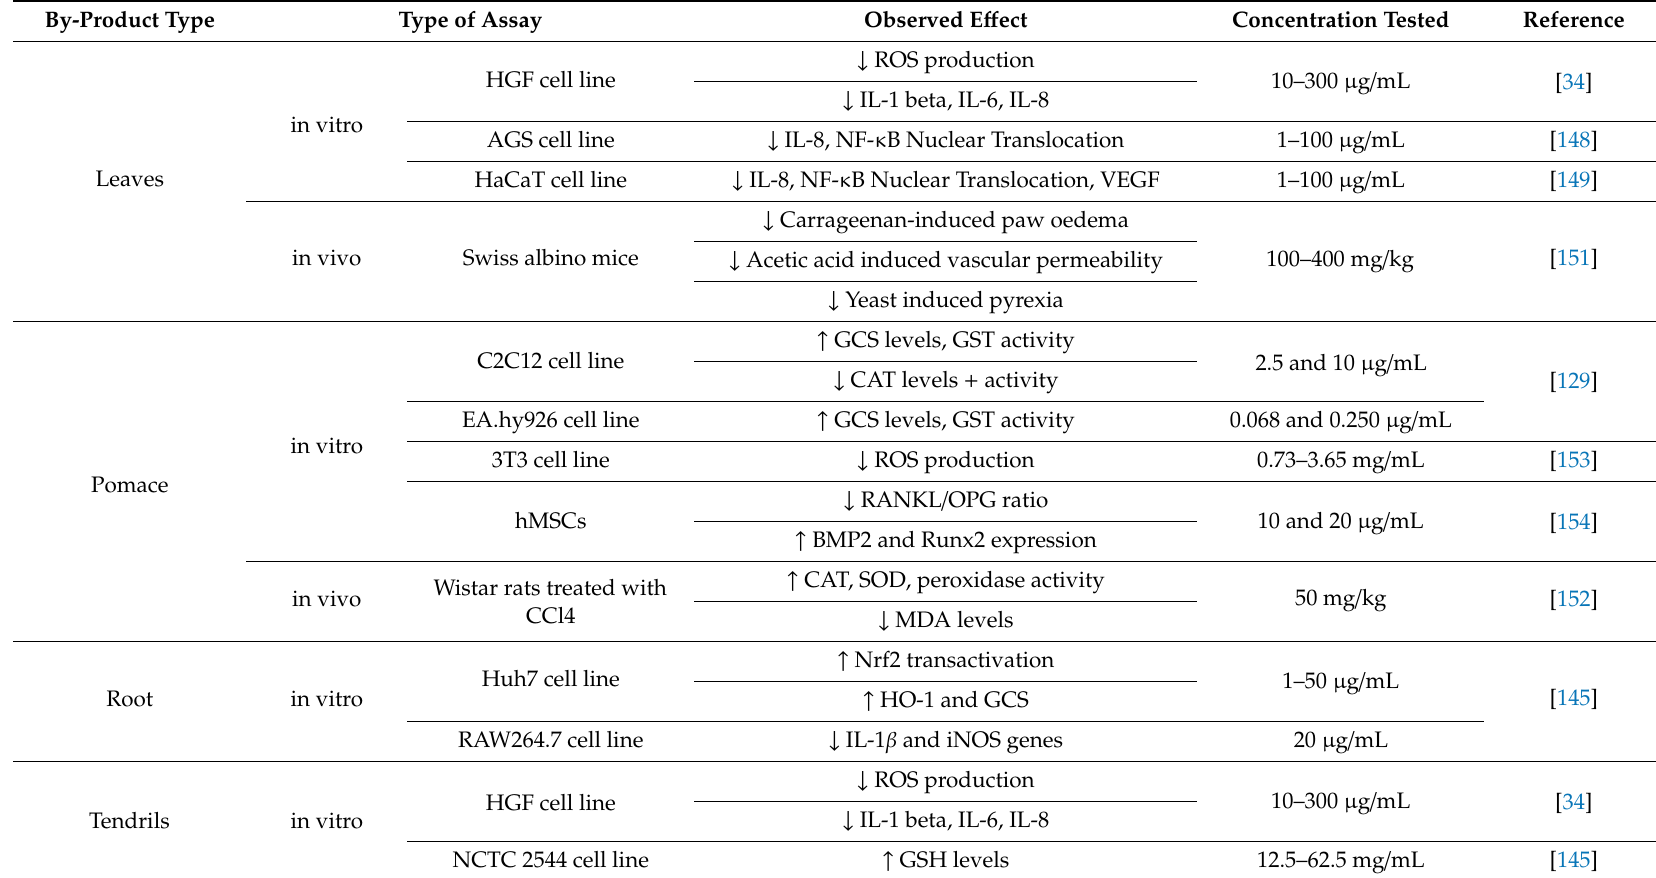
Table 3. Summary of in vitro and in vivo studies investigating antioxidant and anti-inflammatory e ff ects of V. vinifera